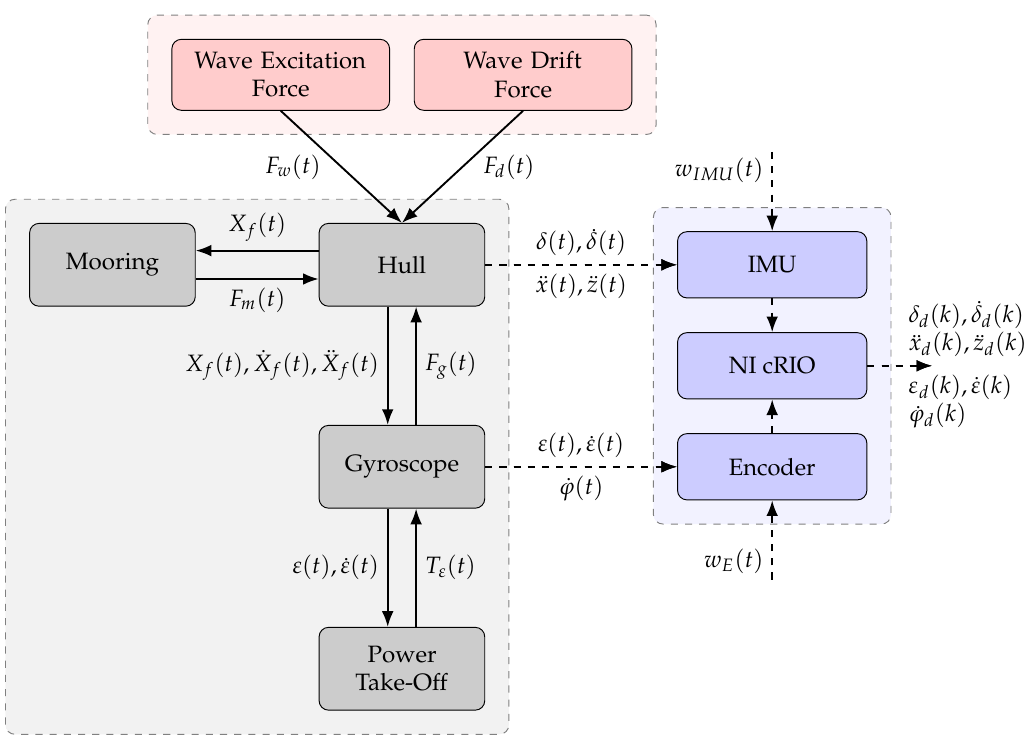
Figure 5. ISWEC device block diagram. Forces and motions in continuos line, signals and disturbances in dashed